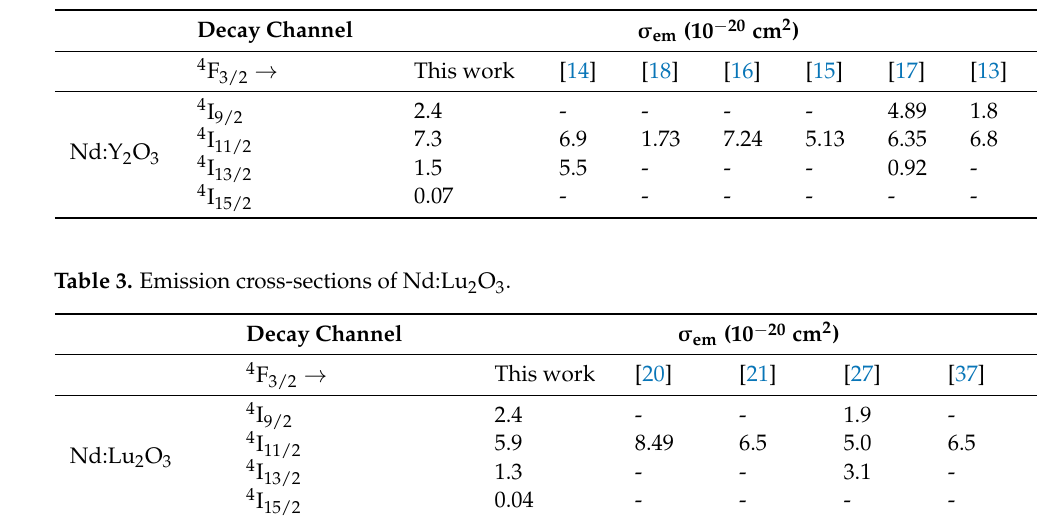
Table 2. Emission cross-sections of Nd:Y 2 O 3 .